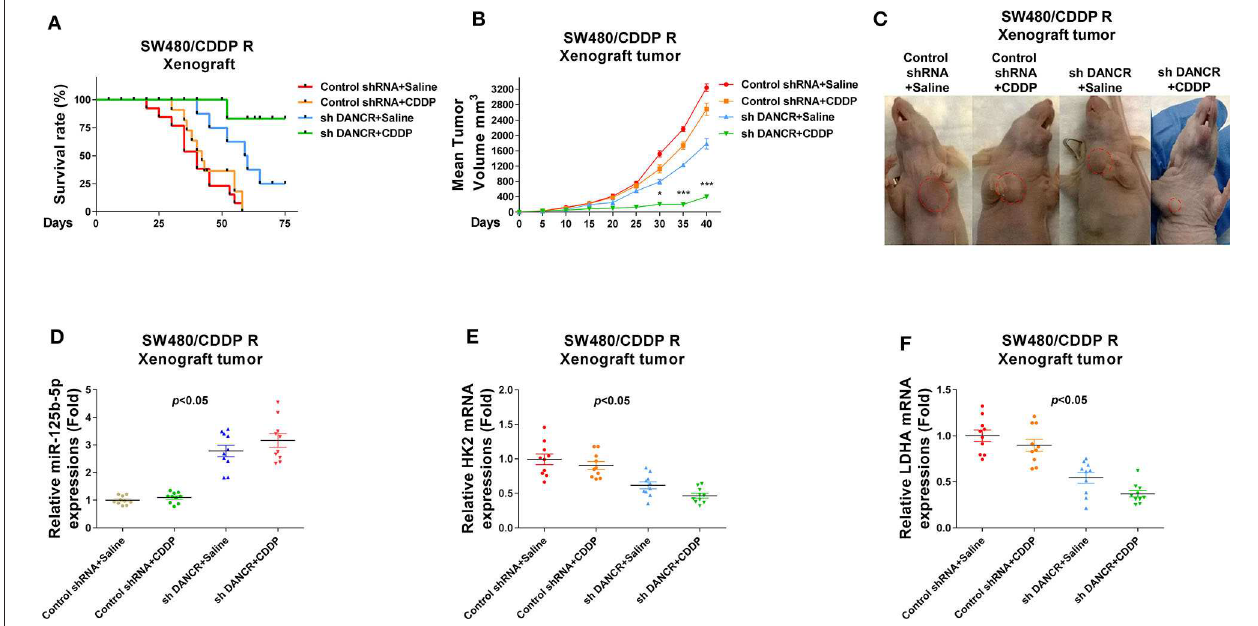
FIGURE 8 | Effects of silencing DANCR on cisplatin resistance of colon cancer in vivo . (A) SW480/CDDP R cells stably transfected with control shRNA or sh DANCR were subcutaneously injected into BALB/c mice ( n = 10). Mice were continually treated with cisplatin or control saline for 2 months. The survival rates of mice were recorded and analyzed. (B) Tumor volumes from the above treated mice were measured each 5 days. (C) Mice from the above treatments were sacrificed, and the tumors from each group were visualized. (D) Expressions of miR-125b-5p, (E) HK2 mRNAs, and (F) LDHA mRNAs in tumors from the above treated mice. Data are presented as mean ± SD. * p < 0.05, and *** p <